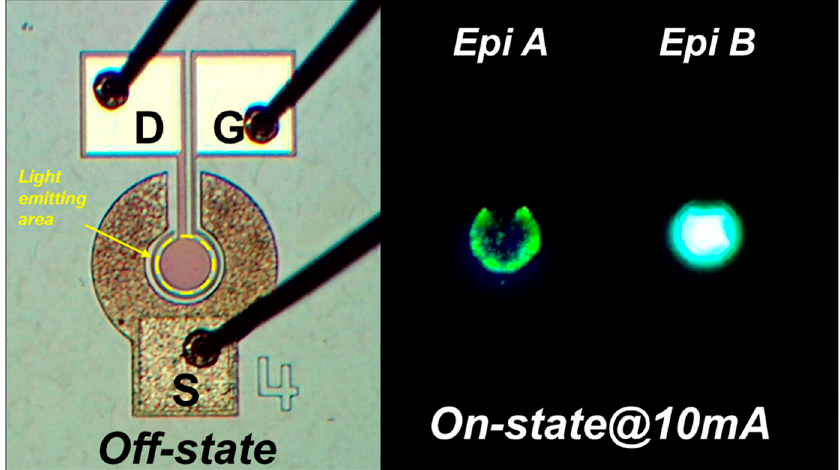
Figure 7. Images of a fabricated LE-HEMT under microscope and light emission when the device is switched on.